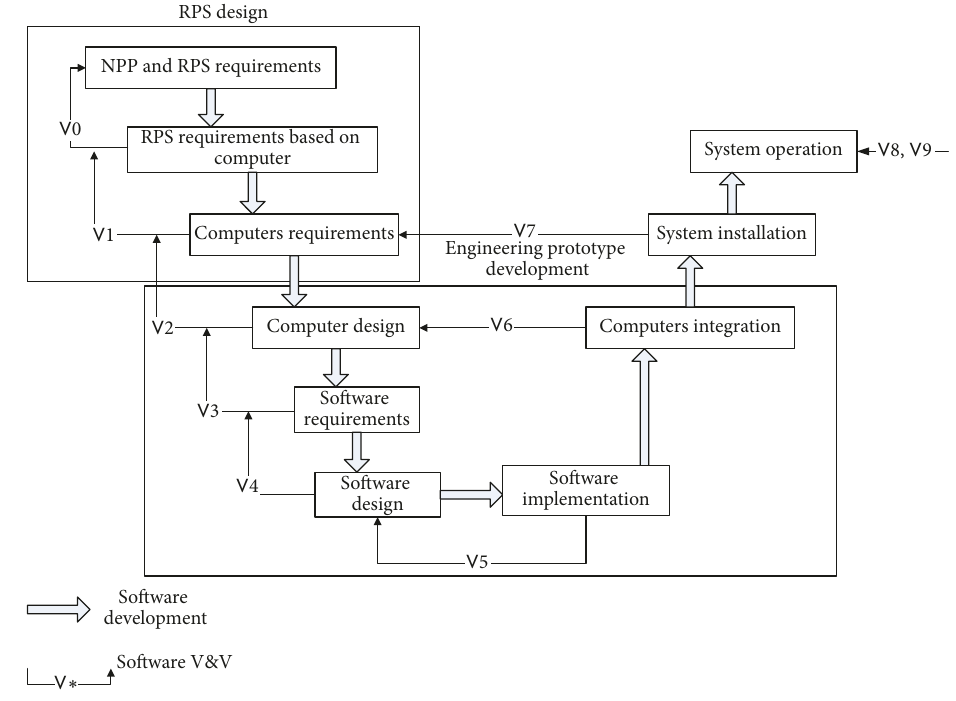
Figure 4: Software verification and validation model of RPS in